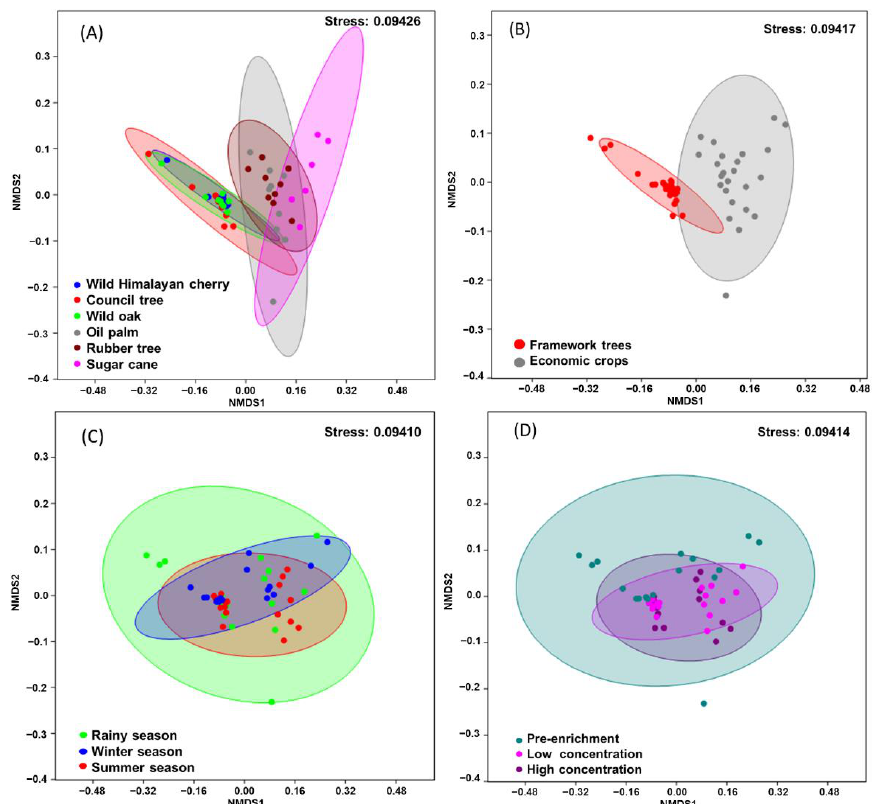
Figure 2. Non-metric multidimensional scaling (NMDS) analysis of bacterial communities, based on Bray–Curtis dissimilarity (using OTUs derived from 16S rRNA gene sequences). Each point represents a single community, with points closer together indicating compositionally similar communities. All panels show the same data with 95% confidence ellipses for ( A ) Plant species, ( B ) Type of plants ( C ) Seasons and ( D ) Isoprene concentrations.